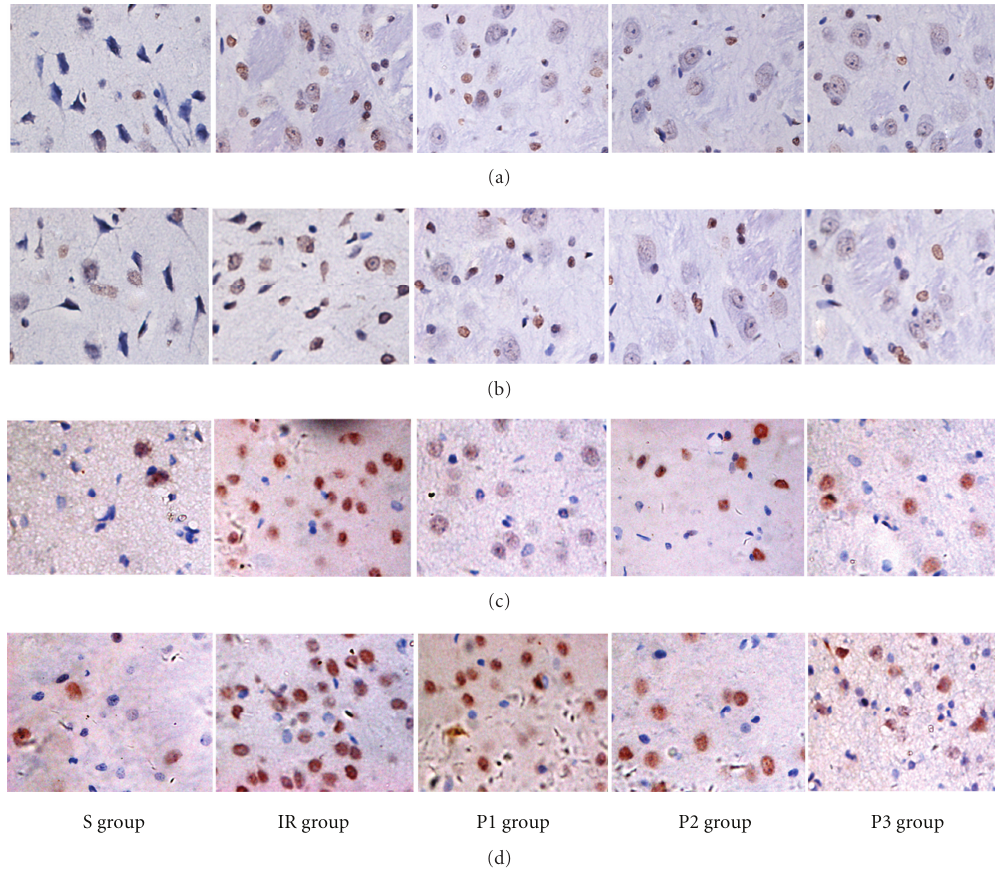
Figure 4: (a) Apoptosis cells in brains by TUNEL assay after 24h ischemia ( × 400). (b) Apoptosis cells in brains by TUNEL assay at 72 h ischemia ( × 400). (c) Apoptosis cells in brains by caspase-3 immunohistochemical stain assay after 24 h ischemia ( × 400). (d) Apoptosis cells in brains by caspase-3 immunohistochemical stain assay after 72 h ischemia ( × 400).